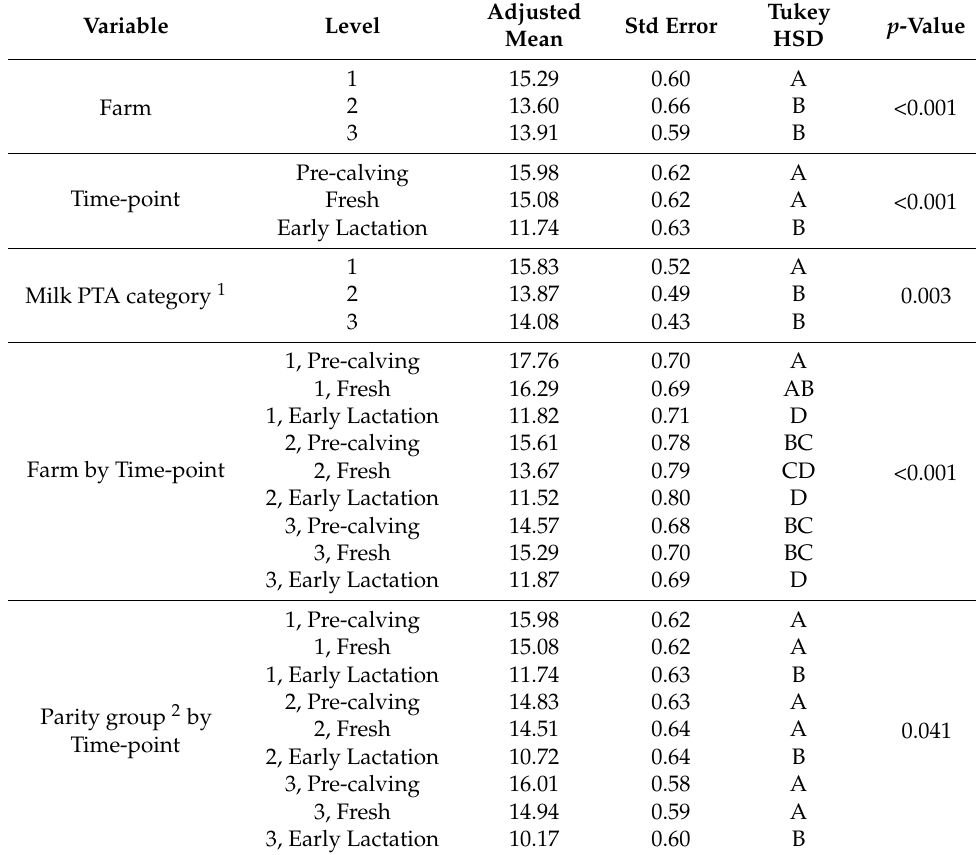
1 Milk PTA category: 1 for the group with the lowest gPTAs for milk production to 3 for the group with the highest gPTAs. 2 Parity group: 1 for cows in their first parity, 2 for cows in their second parity, 3 for cows in their third or Animals 2022 , 12 , x greater parity.